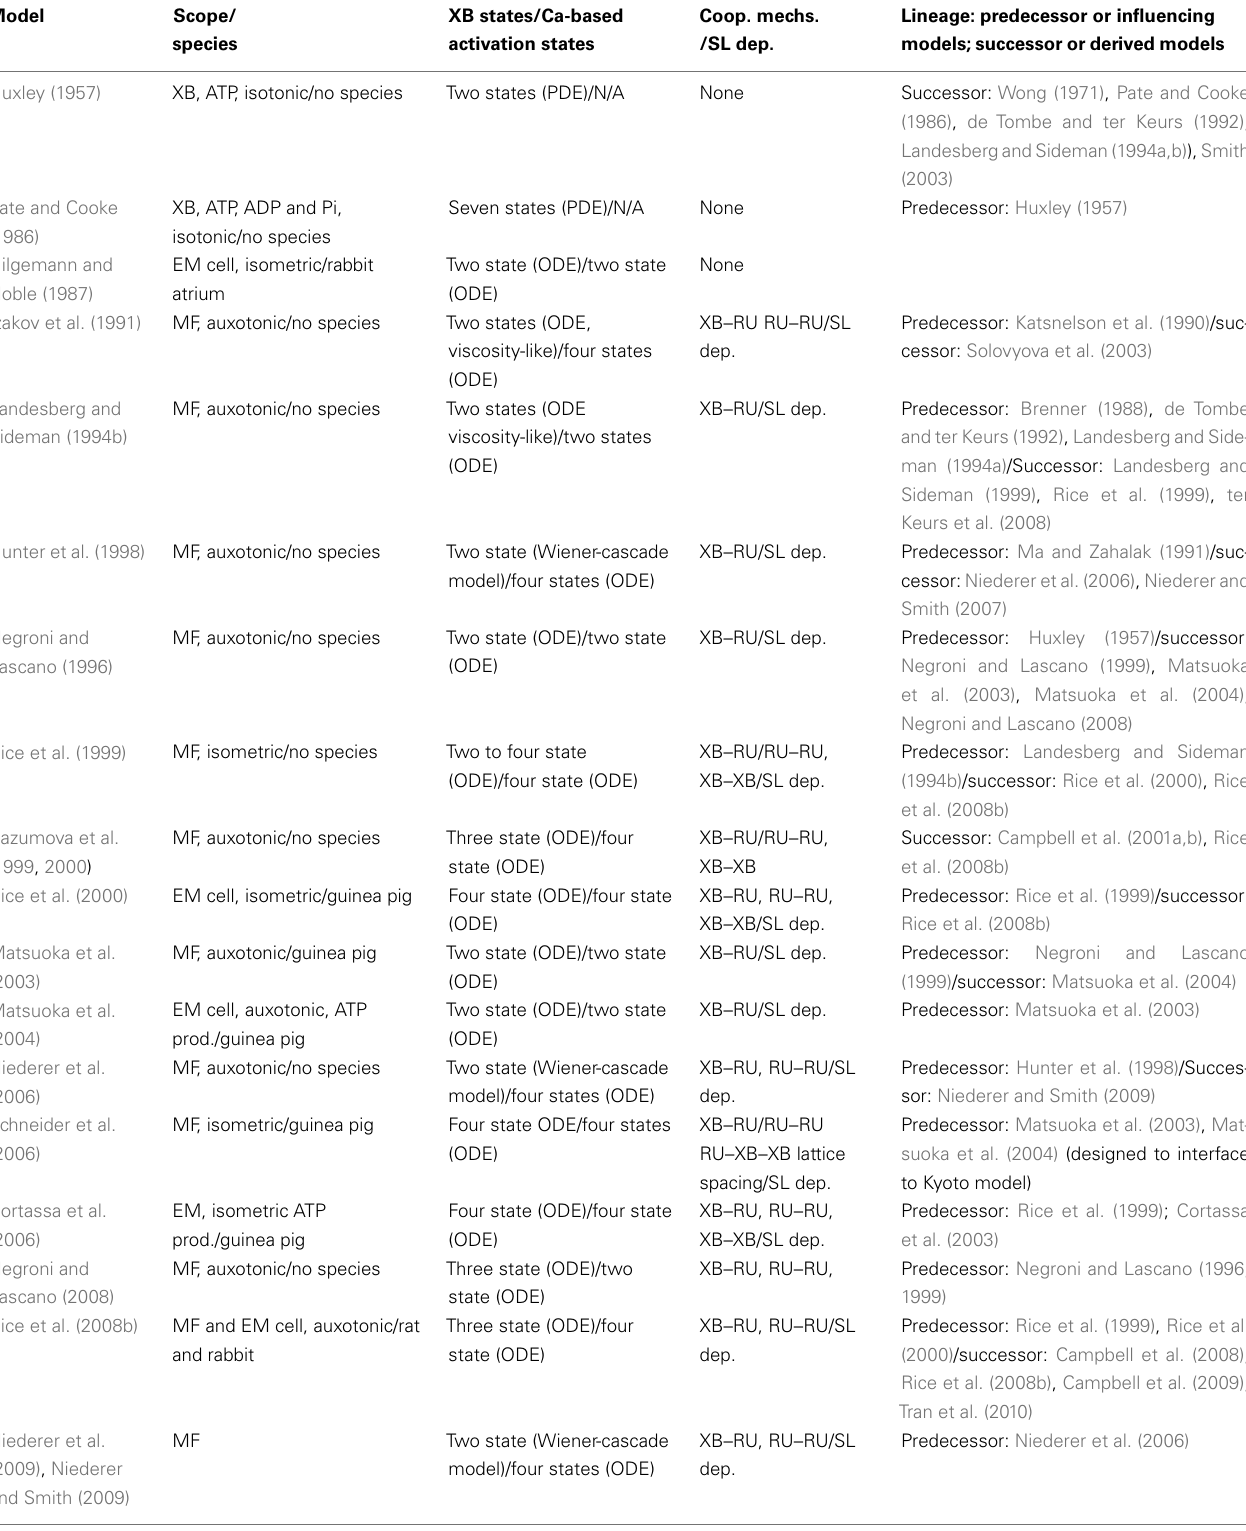
Table 1 | Summary of myofilaments and singe cell EM